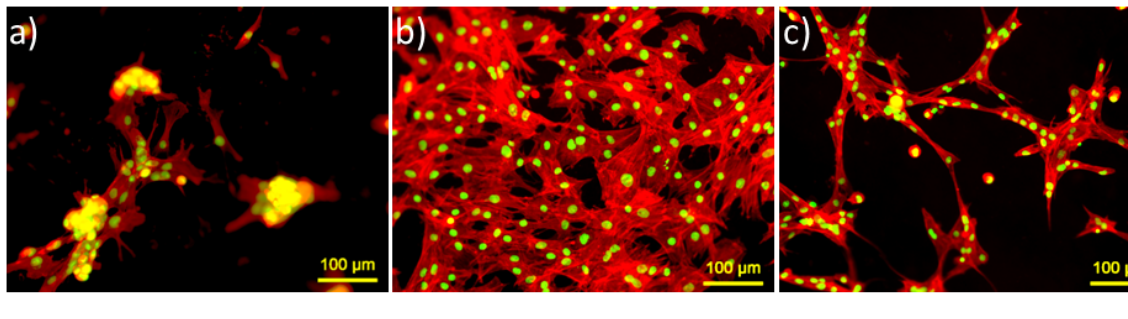
Figure 4. Number of cells per unit area of alginate, ADA-GEL and ADA-GEL-nBG hydrogel films after 48 h of cultivation. Alginate was used as the control material. Asterisks denote significant difference compared to alginate hydrogel, * p < 0.05,